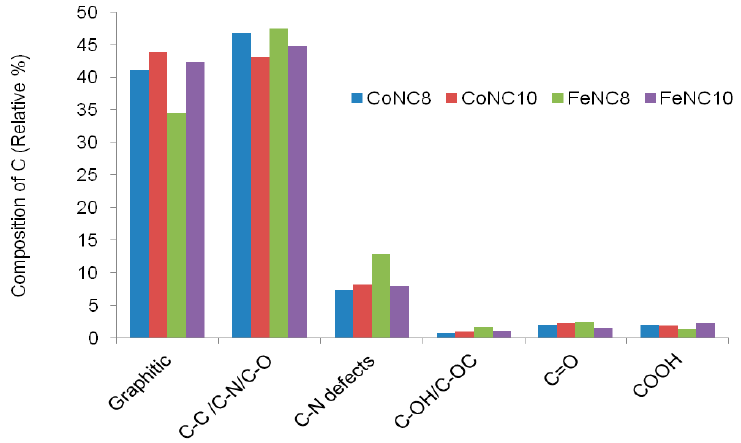
Figure 5. Relative percentage composition of C 1s for CoNC8, CoNC10, FeNC8, and FeNC10 catalysts.